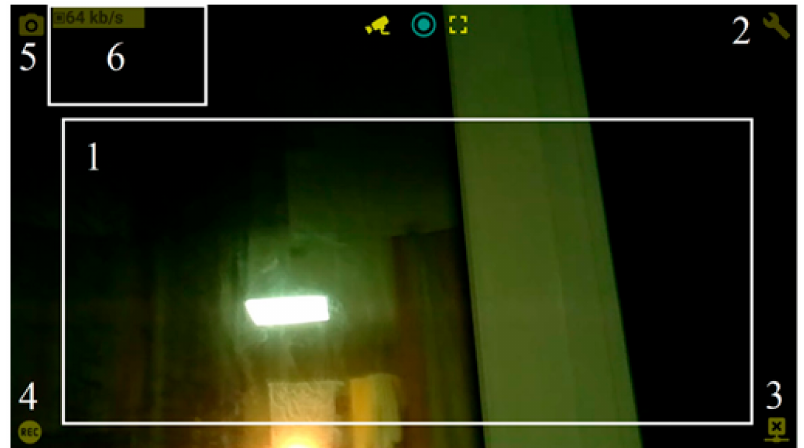
Figure 9. Android app. Video broadcast window 1—video output field from the robot’s cameras, 2 —settings button, 3—”end connection” button, 4—“enable recording” button, 5—“frame capture” button, 6—output field for connection parameters and readings of the robot sensors.